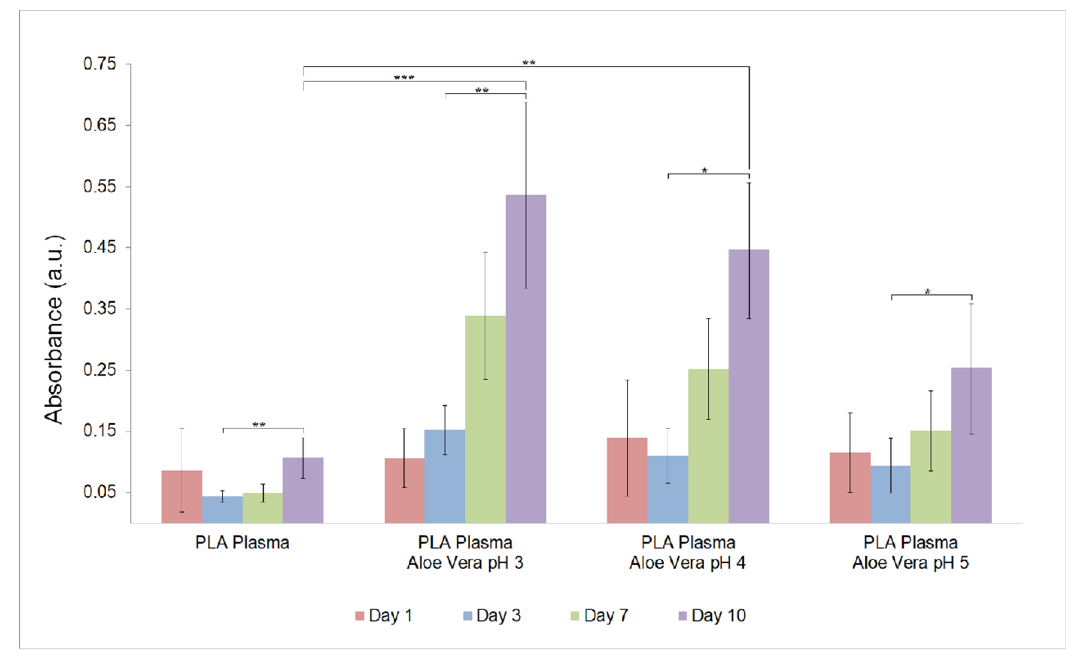
Figure 5. Metabolic activity of human fetal osteoblastic cell line (hFOB) cells on the plasma-treated and coated scaffolds determined by the CCK-8 assay (*p < 0.05, **p < 0.01 and ***p < 0.001).